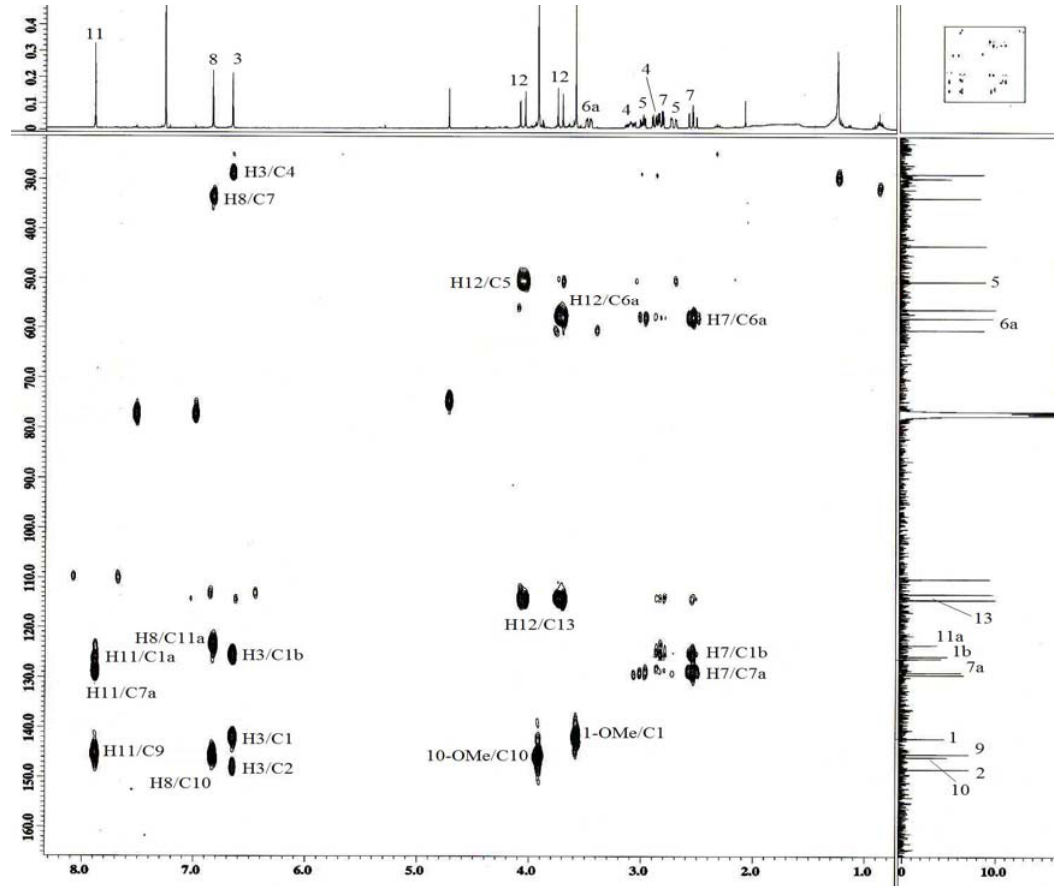
Figure 5. HMBC-NMR spectrum of alkaloid 1 .